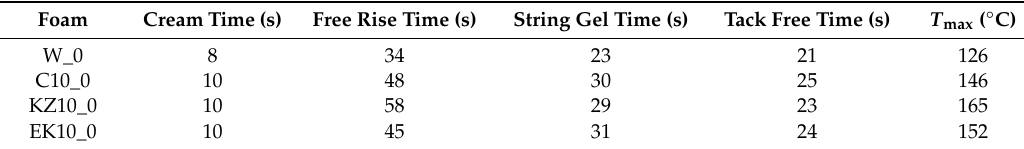
Table 3. Processing times of RPU / PIR foams.